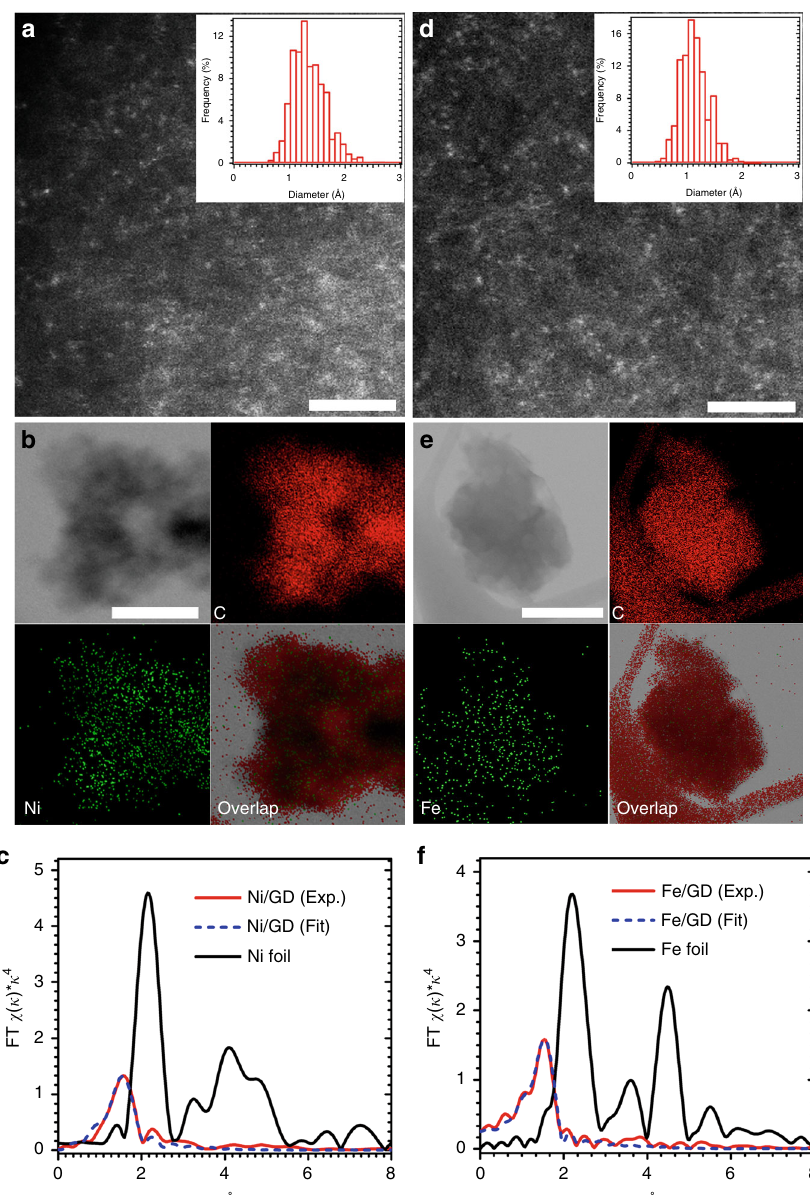
Fig. 3 XAS studies and size distribution. a Additional HAADF-STEM image of Ni/GD [inset: size distribution of Ni atoms counted from HAADF-STEM images (>560 Ni atoms considered, the most probable value is 1.23 ± 0.40 Å)]. Scale bar, 2 nm. b STEM elemental mapping of Ni/GD. Scale bar, 200 nm. c Ex situ EXAFS spectra of Ni/GD and Ni foil at the Ni K-edge. d Additional HAADF-STEM image of Fe/GD [inset: size distribution of Fe atoms counted from HAADF-STEM images (>1070 Fe atoms considered, the most probable value is 1.02 ± 0.33 Å)]. Scale bar, 2 nm. e STEM elemental mapping of Fe/GD. Scale bar, 200 nm. f Ex situ EXAFS spectra of Fe/GD and Fe foil at the Fe K-edge. All atoms counted in the HAADF-STEM images were well separated from their